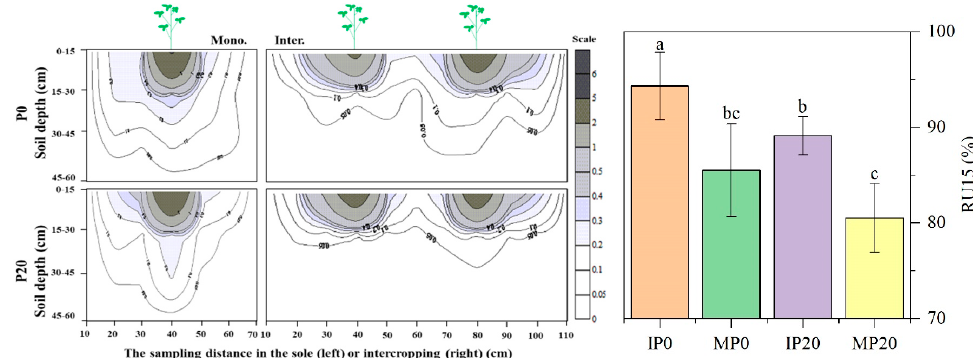
proportion of roots distributed in the upper 15 cm soil layer) of inter-cropped soybeans was significantly ( p ≤ 0.05) higher than monocropped soybeans, irrespective of the cropping system. Compared to P20 treatment, roots distribution was shallower in P0. In the horizontal direction, inter- cropped soybeans allocated more roots to the wide row side, while reduced allocation to the narrow row. For monocropped soybean, the root systems on both sides of the soybean were almost symmetrically distributed (Figure 2).